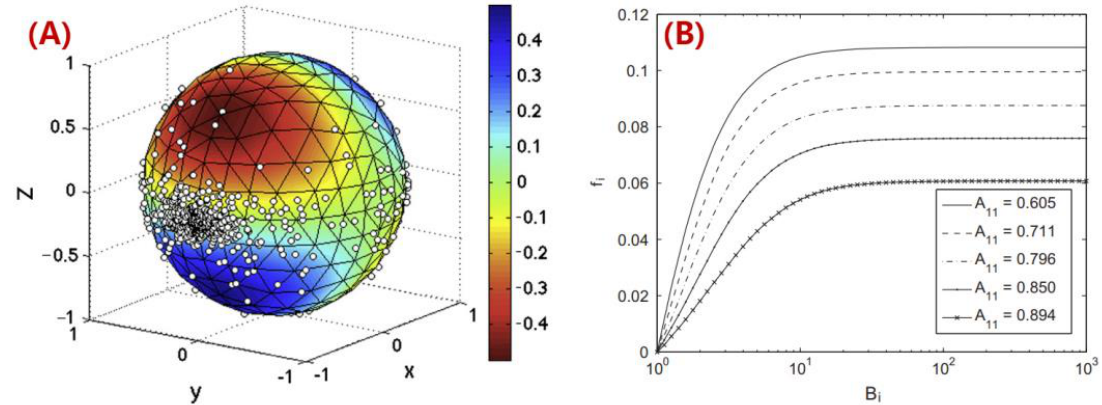
Figure 16. ( A ) Sphere of all possible fiber directions p , colored by the value of ( D : pp ) for the simple shear flow 𝑣 𝑥 = 𝛾̇𝑧 . Negative values (red to yellow colors) indicate orientations where the fiber is in compression. Points on the sphere are a sample of fiber orientations at steady state for this flow, calculated using the Folgar–Tucker model; ( B ) Fraction fi of fibers that have an orientation in which they can buckle, as a function of the buckling parameter B i , for various steady-state orientations in simple shear flow.